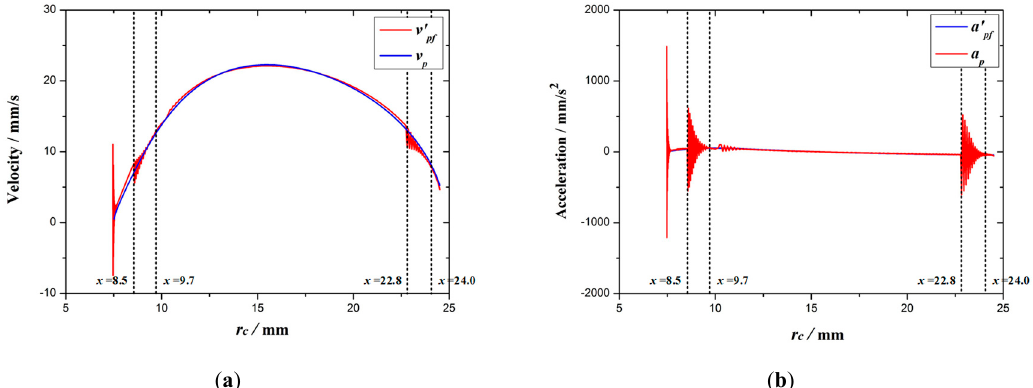
Figure 16. The response curves of velocity ( a ) and acceleration ( b ) after optimization. Table 5. The maximum amplitude of velocity and acceleration with different expanding radius.